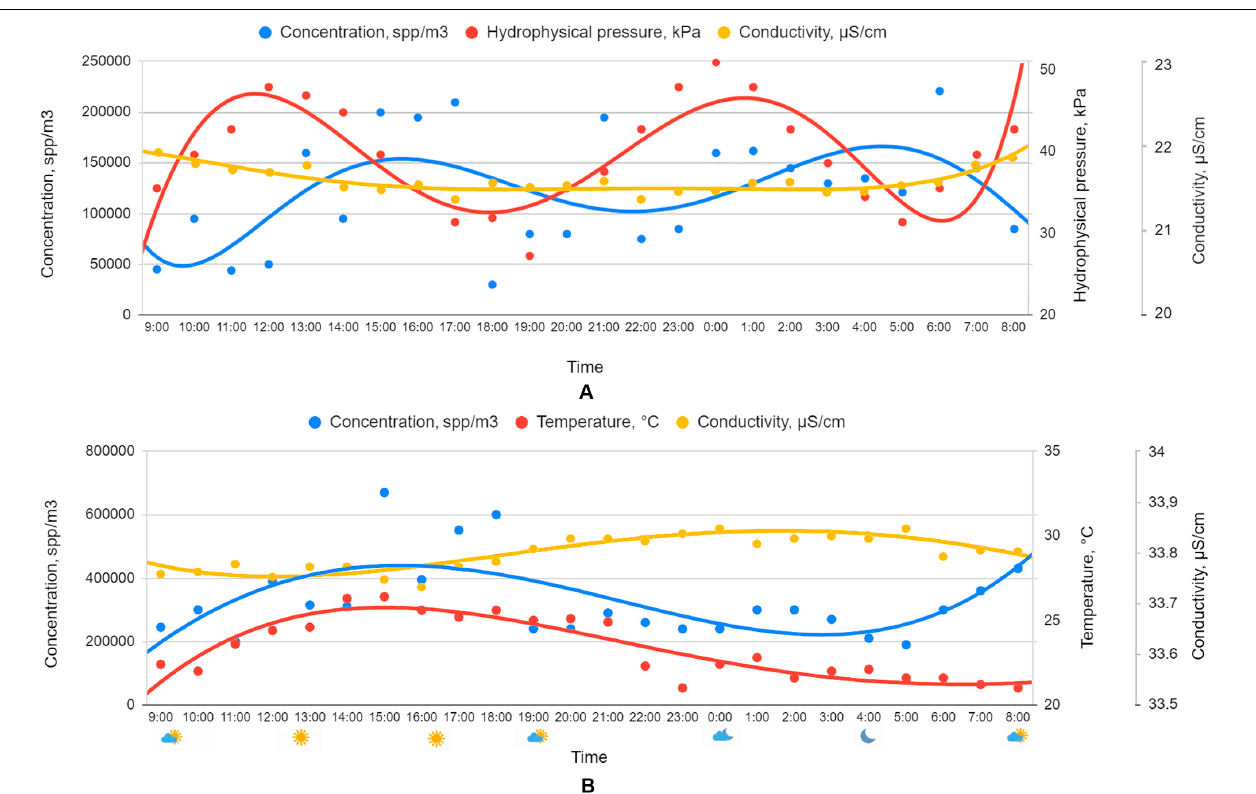
FIGURE 4 | Data obtained with the use of the digital holographic camera as part of the hardware and the software complex (A) in the Kola Bay at the stationary station, at a fixed depth of 1.5 m from the bottom (25.06.2018) and (B) in the Black Sea in the area of the stationary hydrophysical station (28.08.2018). The solid lines indicate (A) 6th- and (B) 4th-degree polynomial